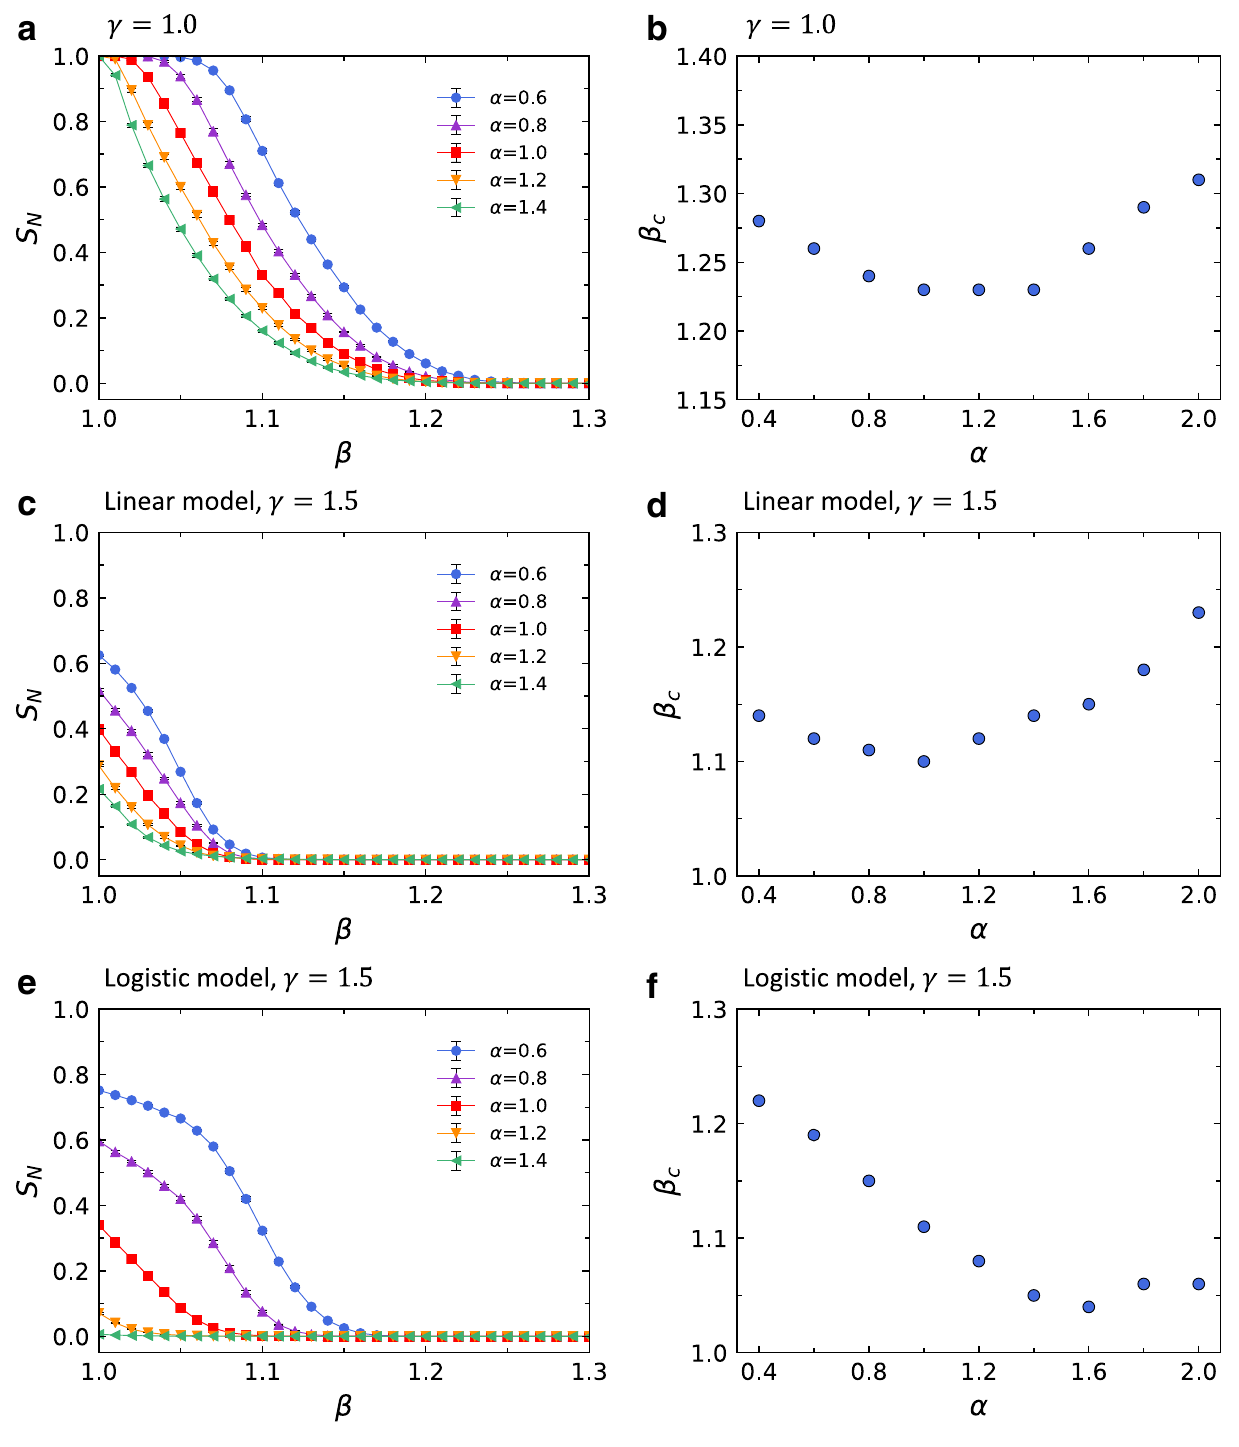
Figure 2. Dependence of the order parameter S N on the tolerance parameter β in Eq. (2) with ( a ) γ = 1.0 , ( c ) linear model with γ = 1.5 , and ( e ) logistic model with γ = 1.5 and the critical threshold β c as a function of the parameter α in Eq. (1) with ( b ) γ = 1.0 , ( d ) linear model with γ = 1.5 , and ( f ) logistic model with γ = 1.5 . The value of γ = 1.5 is chosen in such a way that the lowest curve of S N in ( c ) and ( e ) is close to zero at β = 1.0 . We use the network size N =1000 and the average degree (cid:31) k (cid:30) =6, and each data point is the averaged value for 20 independent runs. Error bars in ( a ), ( c ), and ( e ) are smaller than the symbol size and thus are almost